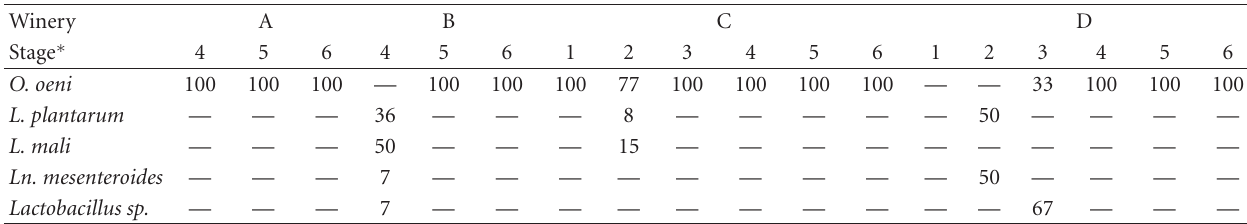
Table 1: Analytical composition of wines at final AF (stage 3) and final MLF (stage 6) in each winery. Winery A B C Stage Alcohol content (% v/v) pH Total acidity (g/L tartaric acid) Volatile acidity (g/L acetic acid) L-malic acid (g/L) L-lactic acid (g/L) Free SO 2 (mg/L) Total SO 2 (mg/L) Total phenols (OD 280 nm) Colour intensity (OD [420 + 520 + 620]nm) Tonality (OD 420/520 nm) Histamine (mg/L) 0.00 (—) not analyzed. Table 2: Percentage of the LAB species at each stage of the vinification in the four studied wineries. Winery A B C D Stage ∗ 4 O. oeni L. plantarum